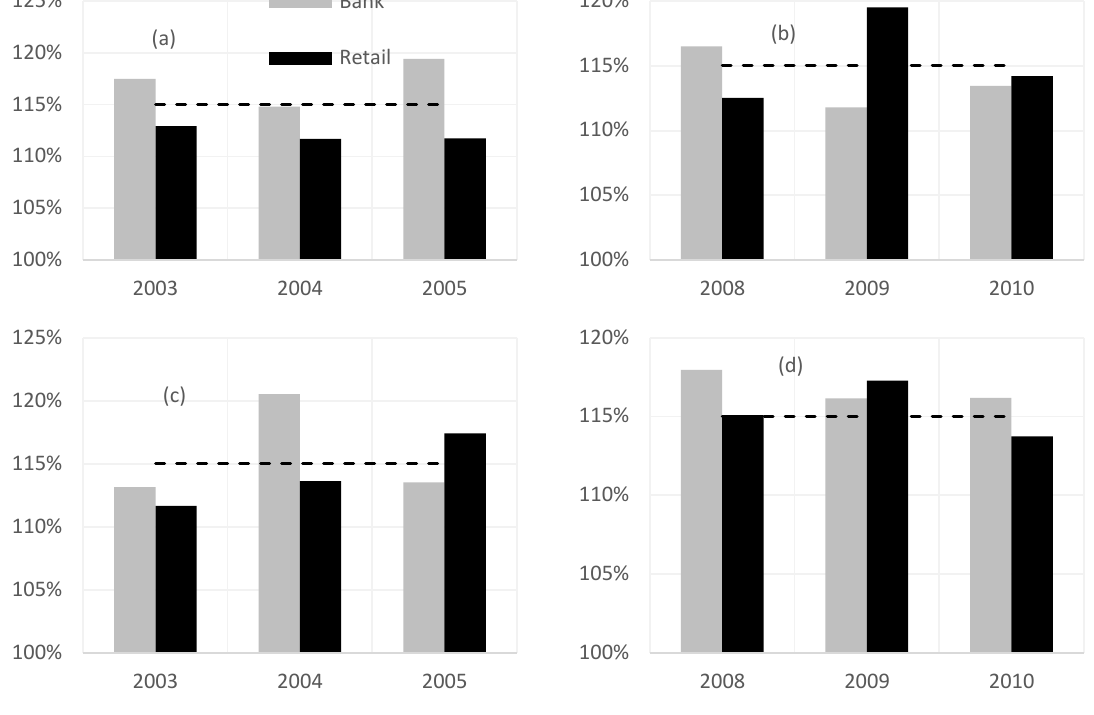
Figure 9. Monte Carlo simulation ES/VaR ratios for (a) SA 03-05, (b) SA 08-10, (c) UK 03-05 and (d) UK